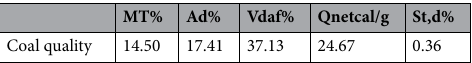
Table 1. Industrial analysis of coal quality.